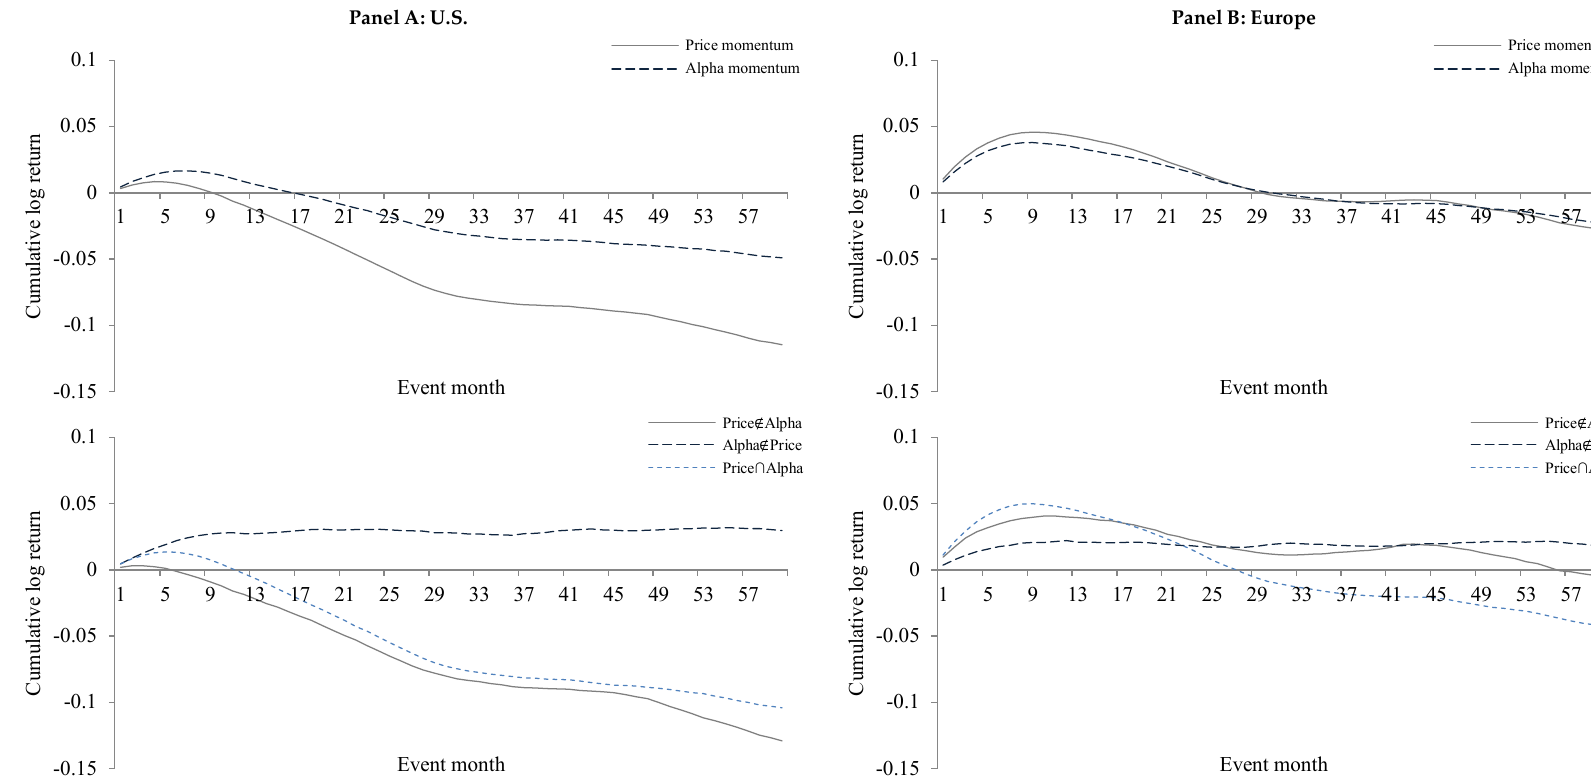
Figure 3. This figure shows the long-term performance of the two momentum strategies and their subset portfolios for a twelve-month formation period. Cumulative log returns per event month are plotted for common price momentum, alpha momentum, “Price ∉ Alpha”, “Alpha ∉ Price” and “Price ∩ Alpha”. For each month t , all stocks with returns for the formation period t − 13 to t − 2 are ranked according to different criteria. The price momentum strategy indicates winner and loser stocks based on their past return. The alpha momentum strategy ranks stocks based on their past alphas. The “Price ∉ Alpha” momentum strategy buys (sells) stocks that are in the winner (loser) decile based on past return, but not based on past alpha. The “Price ∩ Alpha” momentum strategy invests in those stocks that can be in the two extreme deciles according to both past return and past alpha at the same time. The “Alpha ∉ Price” momentum strategy contains stocks that are winner or loser stocks based on their past alpha, but not on their past return. Results are presented in Panel A for the U.S. based on an evaluation period from January 1984 to December 2013 and in Panel B for Europe on an evaluation period from January 1990 to December 2013.